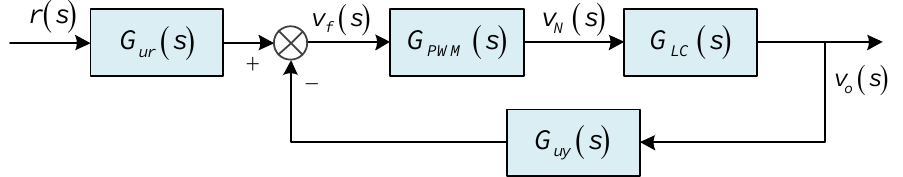
Figure 4. The transfer function of the fundamental voltage control